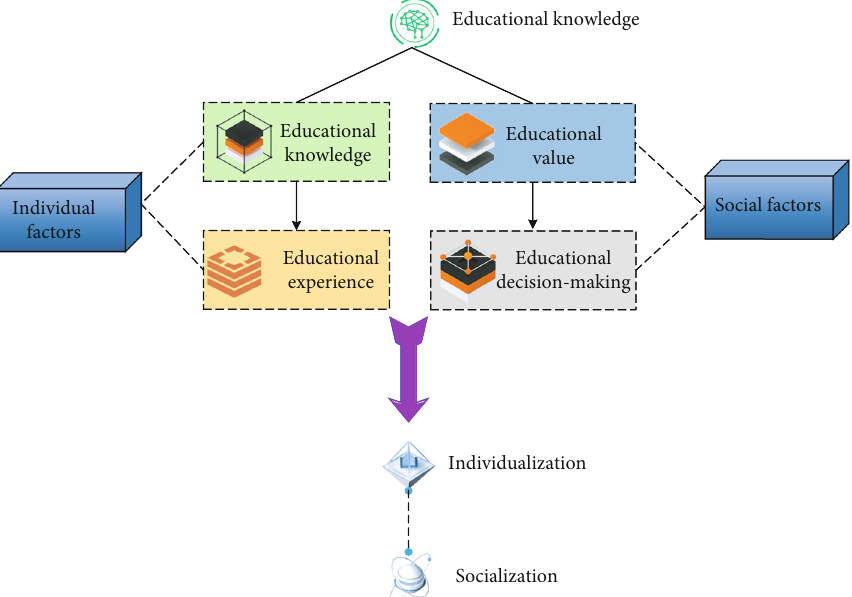
Figure 3: Educational cognitive